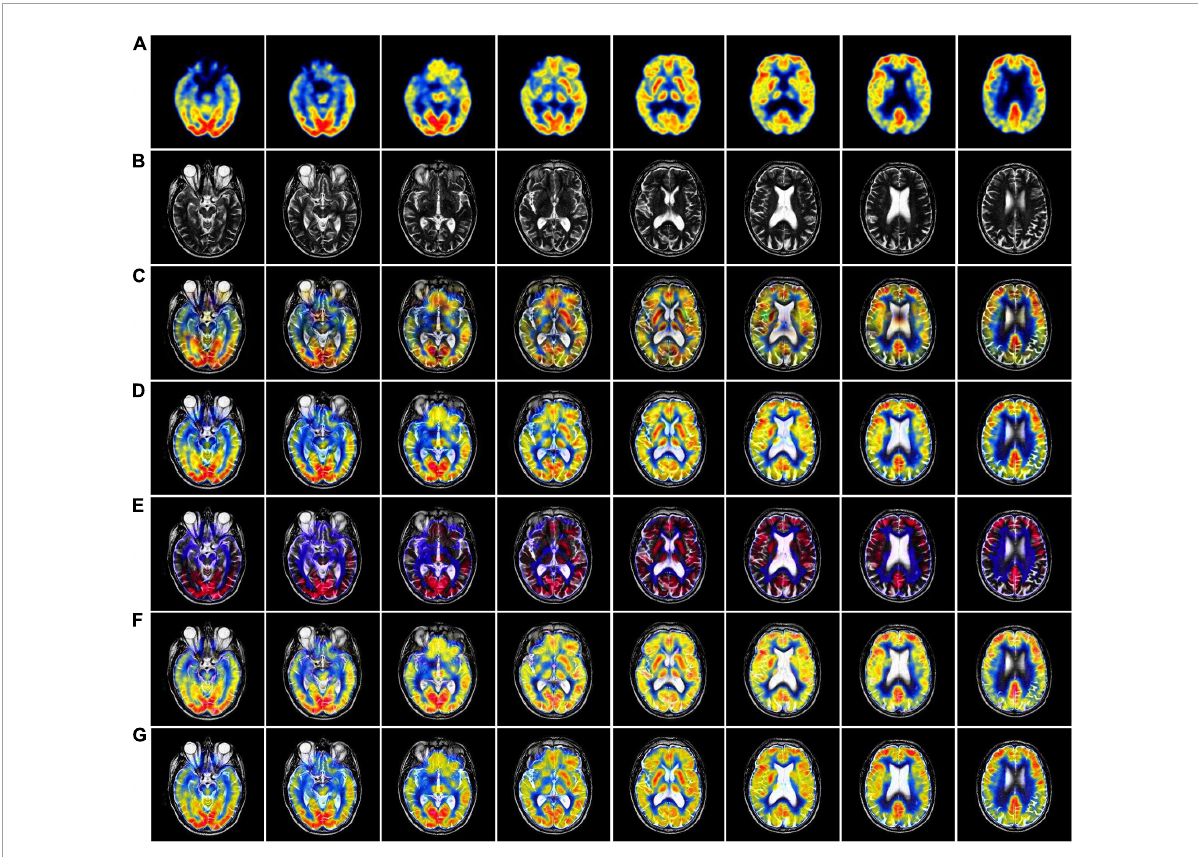
FIGURE5 MRI-PET fusion images of five methods in Paras2. (A) Positron emission tomography (PET) source image; (B) magnetic resonance imaging (MRI) source image; (C) nonsubsampled contourlet (NSCT) fusion result; (D) non-subsampled shear wave transform (NSST) fusion result; (E) guided